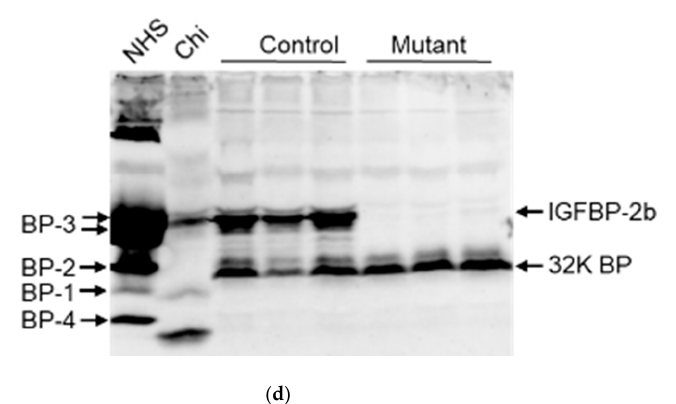
Figure 1. Panels a through c represent examples of chromatograms, indicating amplicons from ( a ) un-injected fish ( a ), injected controls ( b ), and high-rate IGFBP-2b mutants ( c ). Black asterisk indicates intact TYR2, red asterisk indicates intact IGFBP-2b1, and green asterisk indicates intact IGFBP-2b2. Panel ( d ) shows a representative Western ligand blot indicating IGFBP abundance in serum from control and IGFBP-2b mutant rainbow trout. Arrows on the left indicate known IGFBP in normal human serum (NHS). The arrows on the right indicate IGFBP-2b and a 32 kDa IGFBP in rainbow trout. Chi: Chinook salmon.